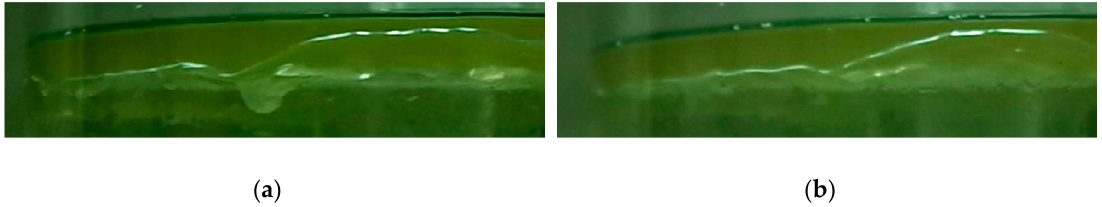
Figure 22. Morphology of steel-slag interface in mold for SEN before and after optimization. ( a ) Original nozzle; ( b ) Optimized swirling nozzle.